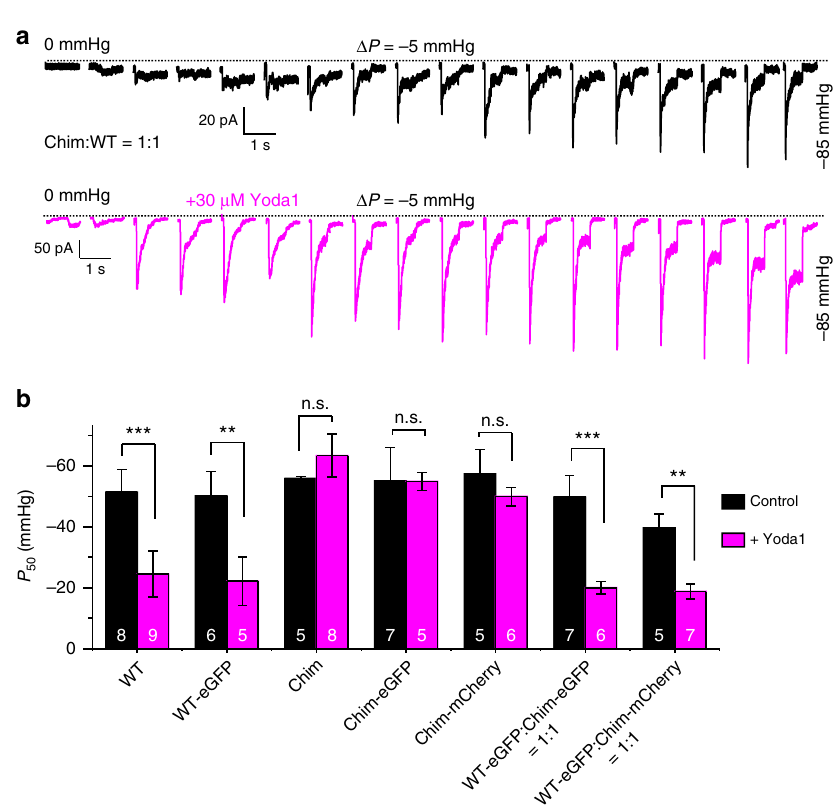
Fig. 6 Yoda1 activates Chim:WT hybrid channels similarly to WT Piezo1. a Example of pressure-induced ionic current recordings in cell-attached patches from cells transfected with an equimolar mixture of WT and Chim plasmids. Dotted lines indicate zero current level. b Histograms showing P 50 values for the indicated Piezo1 constructs in the presence (magenta bars) or absence (black bars) of 30 µ M Yoda1. The effect of Yoda1 on P 50 was tested for each construct using a student t -test. Asterisks indicate standard p -value range: **: 0.001 < p < 0.01; ***: p < 0.001; n.s.: non-signi fi cant. In a and b , V = − 80 mV. In b , error bars = s.e.m. and the numbers in each bar indicate the number of recordings